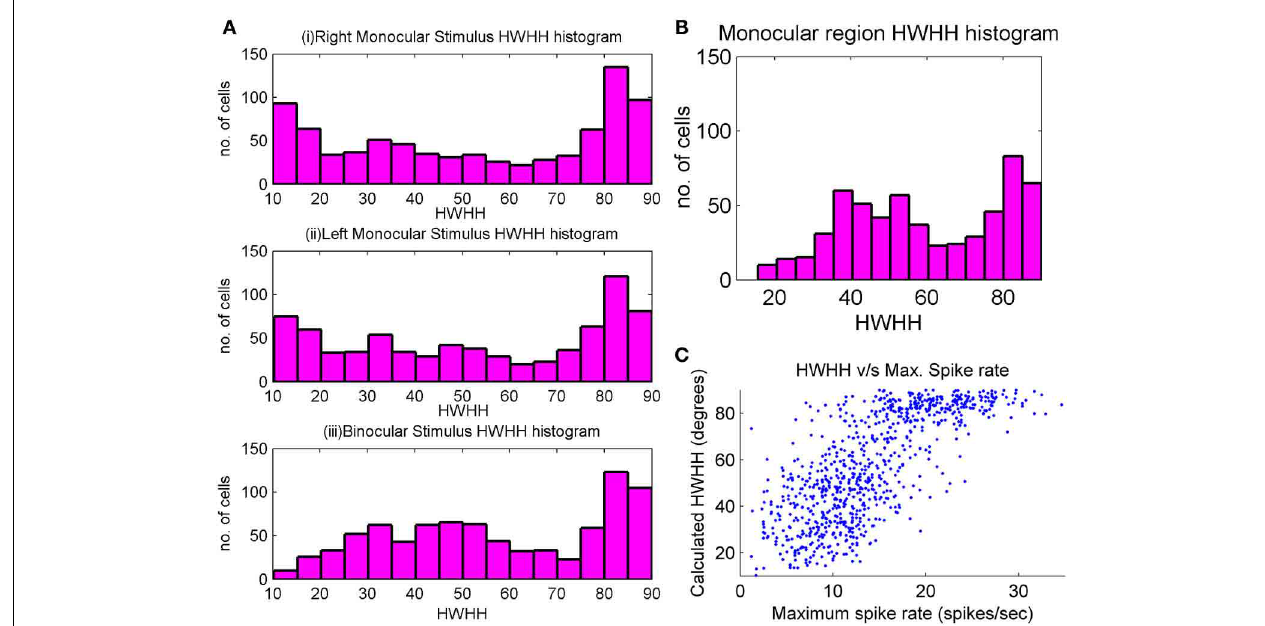
FIGURE 4 | (A) HWHH histogram of the left monocular, the right monocular, and the binocular responses for cortical cells in a 35 × 60 section inside the binocular region. There is a large chunk of cells which are poorly orientation tuned, but there is also a large number of cells with good orientation tuning.